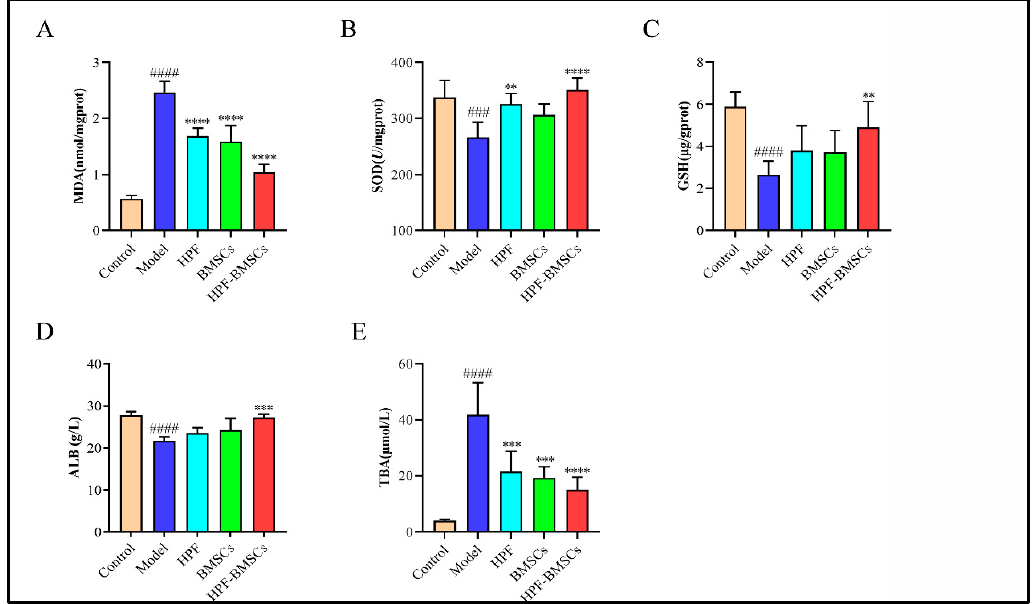
Figure 7. The combined treatment of HPF and BMSCs changed the liver antioxidant enzyme activity of mice with ALI, induced by CCl 4 . The activities of ( A ) MDA, ( B ) SOD, ( C ) GSH, ( D ) ALB, and ( E ) TBA. ### p < 0.001 and #### p < 0.0001 compared with control group, ** p < 0.01, *** p < 0.001 and **** p < 0.0001 compared with the model group.